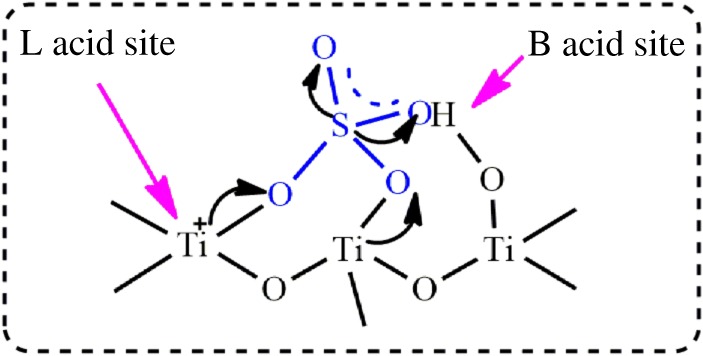
Illustration of the Brønsted and Lewis acid sites in SO42−/TiO2 catalyst.